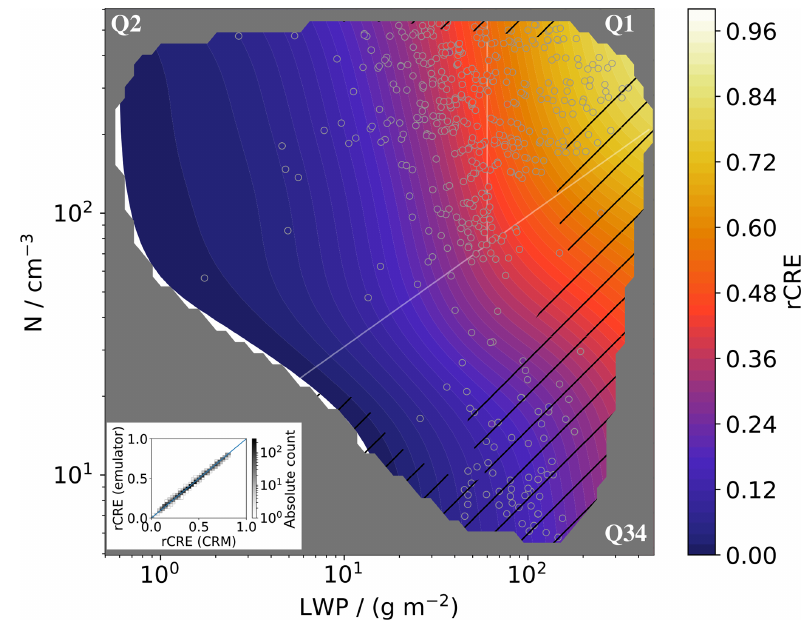
Figure 5. Emulated rCRE surface (ensemble mean Eq. 3) as a function of LWP and droplet number, N , as color contours. The standard deviation, σ , of the emulated rCRE over the ensemble (Eq. 4) is indicated by hatching, with σ < 0 . 01 and 0 . 01 < σ < 0 . 05 for nonhatched and hatched regions, respectively. Emulated values outside [ 0 , 1 ] are masked. Color-filled circles with gray outline show the validation subset of the total dataset shown in Fig. 1 (see Sect. 3.1). For visibility, only every 10th validation data point is shown. The color scale for the data points is the same as for the contours and the gray outline of their edges has been added to distinguish validation data from the emulated surface (see Fig. 9 for an example of this type of plot where values of data points and surface differ more). The scatter plot in the inset compares the complete validation dataset to the emulated values. White lines indicate quadrants as in Fig.